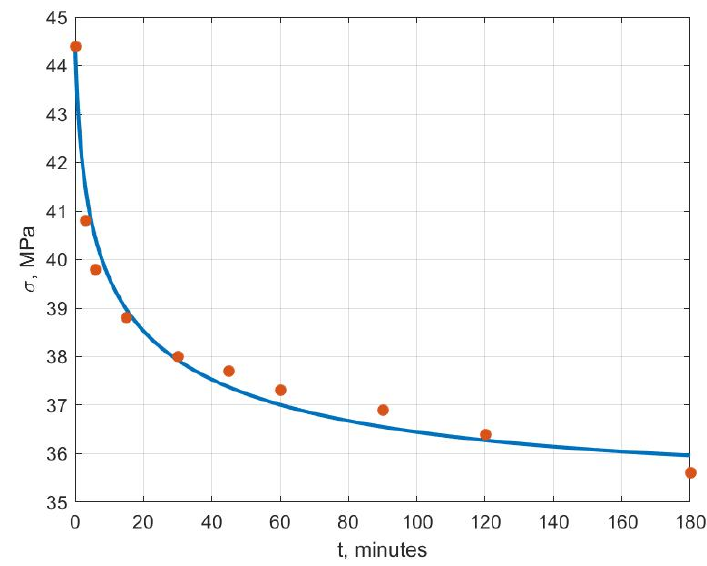
Figure 6. Stress relaxation curve at 𝑇 = 20 °C .